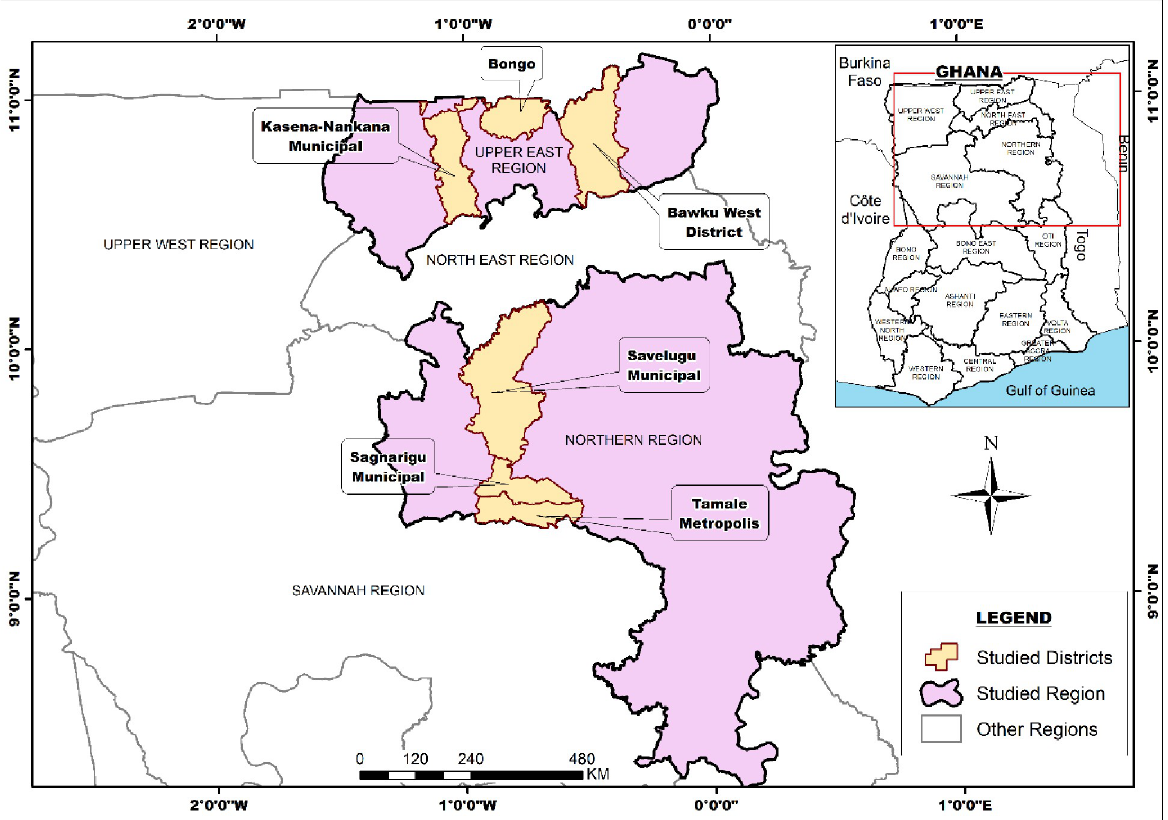
Fig 2. Map of the Upper East and Northern regions of Ghana, showing selected districts of